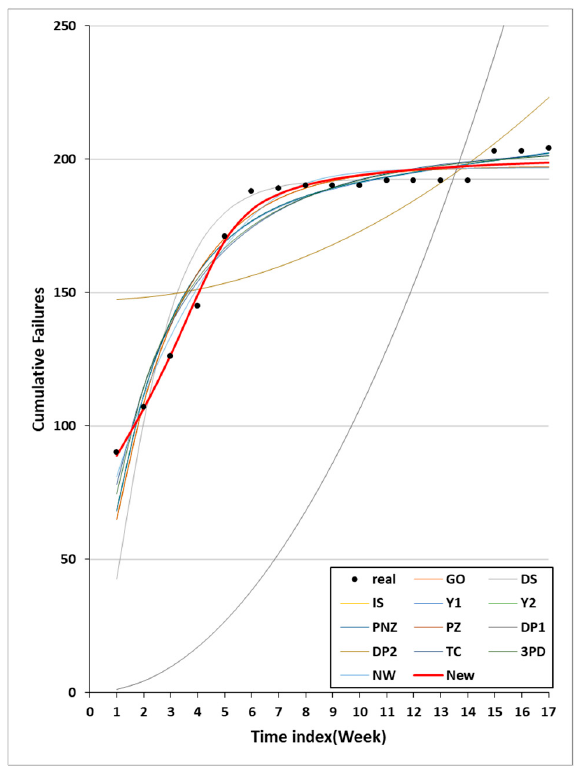
Figure 3. Actual data and estimated mean value function for Dataset #2.